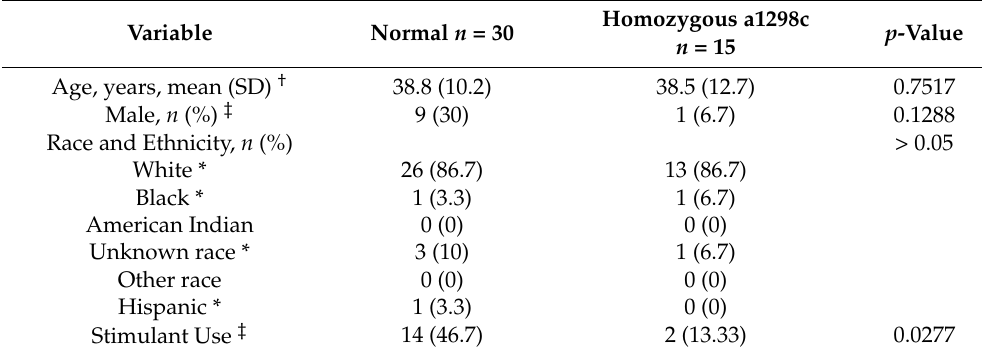
Table 4. Homozygous A1298C compared to those with a normal MTHFR